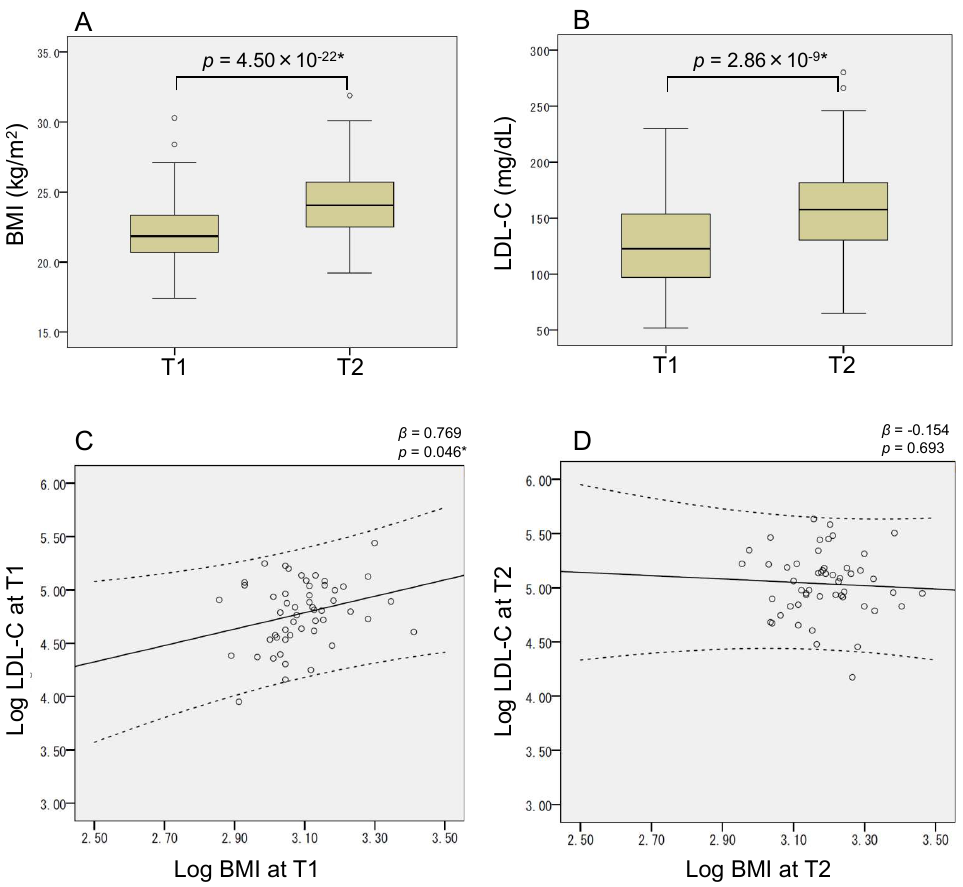
Figure 1. Adiposity traits. ( A ) BMI and ( B ) LDL-C were increased from time point T1 to T2 during mid-to-late gestation. Box and whisker plots illustrate medians, minimum values, maximum values, and interquartile ranges. Scatter plots showing the relationship between BMI and LDL-C at ( C ) T1 and ( D ) T2. ( C , D ) Because of the right-skewness, BMI and LDL-C were log transformed. Solid line, a regression line; dotted line, 95% confidence intervals. Statistics were calculated using ( A , B ) paired t - testing and ( C , D ) regression analysis. (BMI, body mass index; LDL-C, low-density lipoprotein cholesterol) .